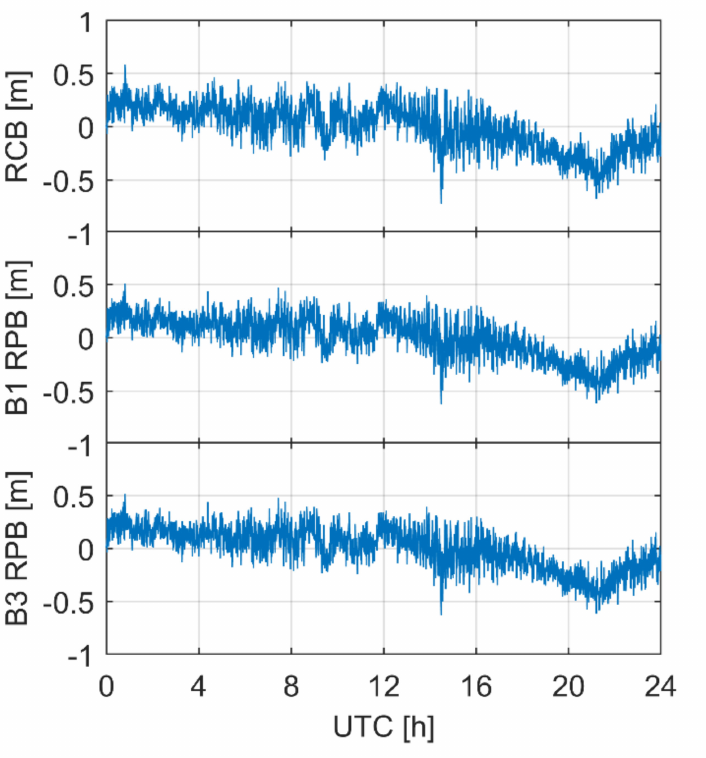
Figure 4. Time series of the BDS RCB and RPB at two frequencies calculated using the IGG1–IGG2 baseline data collected on DOY 268,